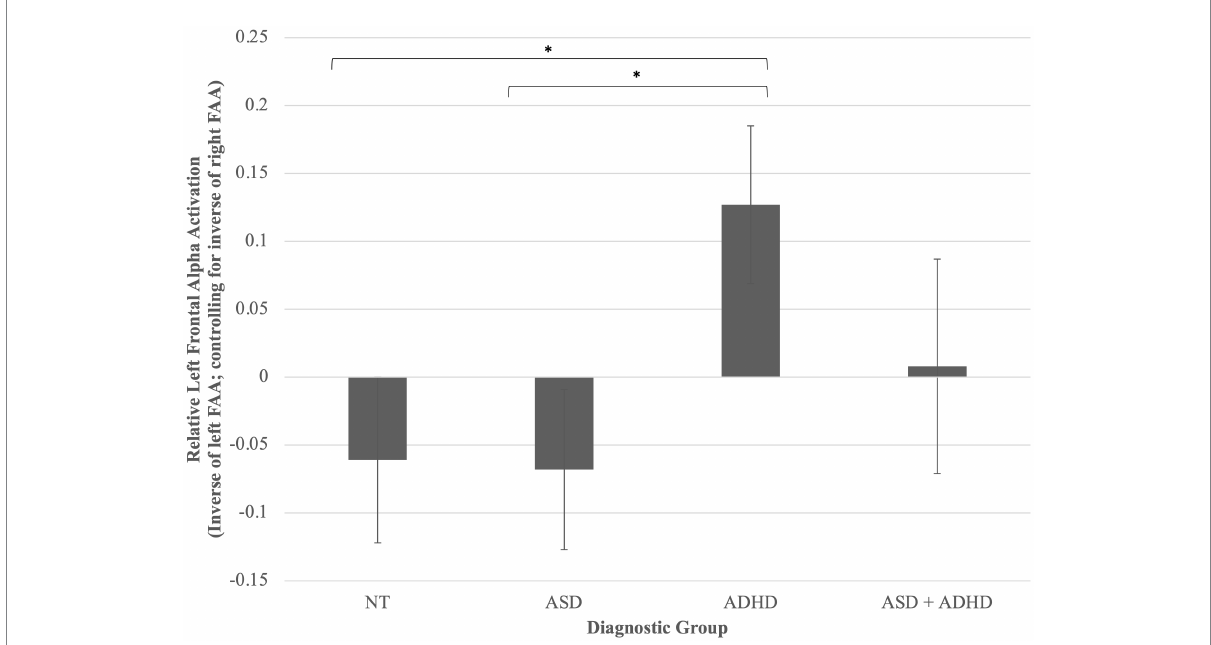
FIGURE 1 Group differences in left frontal alpha activation (relative to right). Children with ADHD displayed greater left (relative to right) FAA compared to both autistic, p = 0.020, and neurotypical children, p = 0.022, but not children with ASD + ADHD, p = 0.234. * p < 0.05. Error bars are +/ − one standard error.